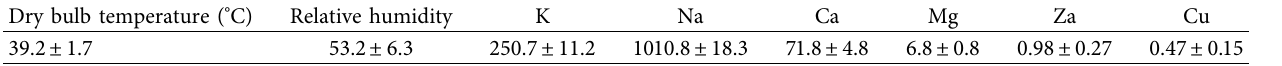
Table 1: The number of inorganic elements lost in 1L sweat.